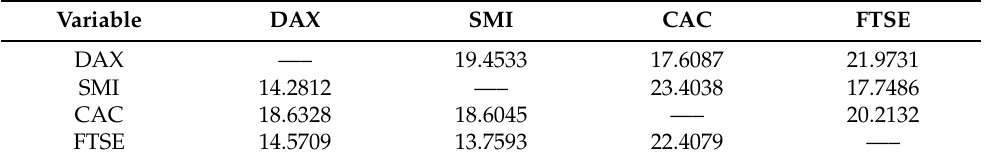
Table 4. TCE Risk measures for θ = 0.95 and t = 0.95 with bivariate Gaussian copula with ρ = 0.9 (left panel) and bivariate Gaussian copula with ρ = 0.95 (right panel). Variable DAX SMI CAC FTSE